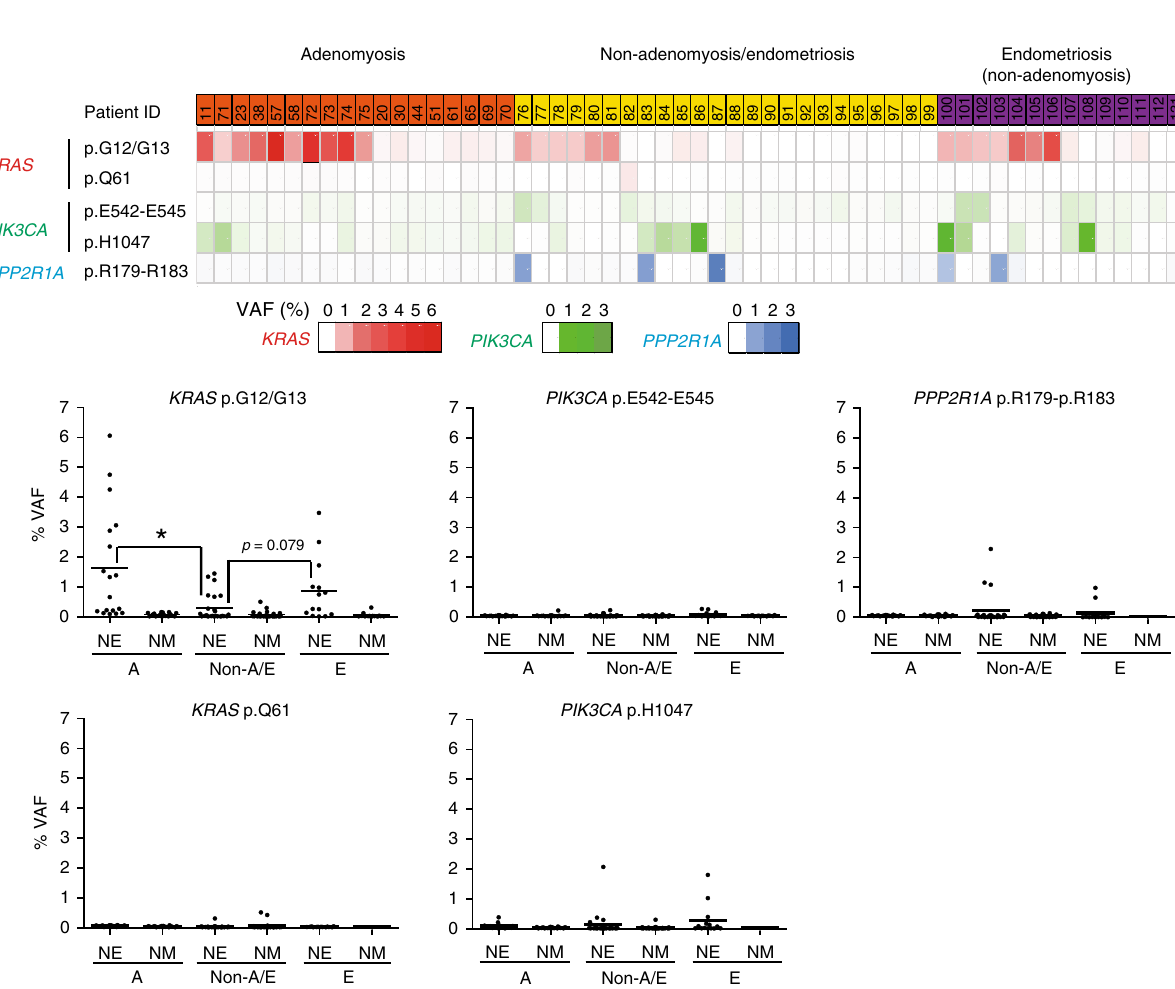
symptoms. GnRHa was mainly used to improve blood hemoglobin levels in patients with severe anemia due to heavy menstrual bleeding (HMB). For GnRHa treatment, subcutaneous injection of 1.88mg leuprorelin acetate or 1.8mg goserelin acetate was initiated during menstruation and repeated every 4 weeks. DNG was used to relieve symptoms in patients with dysmenorrhea alone, whereas LNG-IUS was used for those with dysmenorrhea and HMB. For DNG, daily oral administration of 2 mg was started on days 2 – 5 of menstruation. For LNG-IUS, 52 mg LNG was inserted into the uterine cavity on day 7 of menstruation.